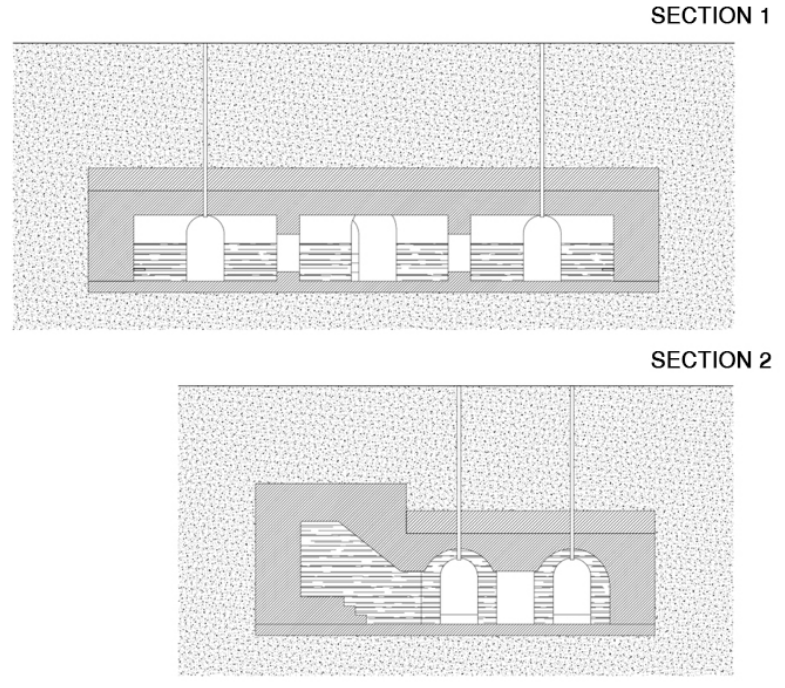
Figure 7. Section of the Plaza Balmis shelter with the three corridors connecting the three spaces that divide the two